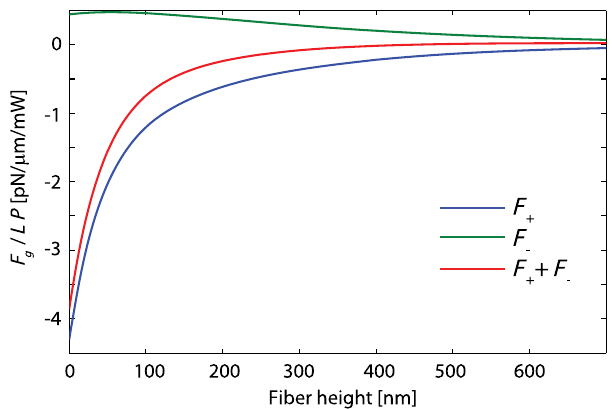
p ffiffiffiffiffi S o . In the x